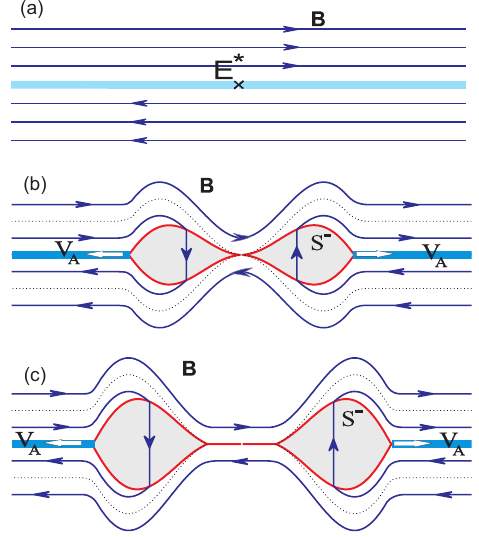
Fig. 28. Schematic illustrating the effects of time-varying recon- nection in a symmetric geometry. In (a) reconnection is initiated through the appearance of a reconnection electric field in a local- ized part of the current sheet. In (b) , during the switch-on phase, two outflow regions bounded by slow shocks S − propagate along the current sheet away from the reconnection site. The structure of magnetic field and plasma flow in the vicinity of the X-line is very similar to the steady-state Petschek model (Petschek, 1964). In (c) , the reconnection electric field has dropped to zero. During this switch-off phase, the outflow regions become detached from the reconnection site, but continue to move along the current sheet.